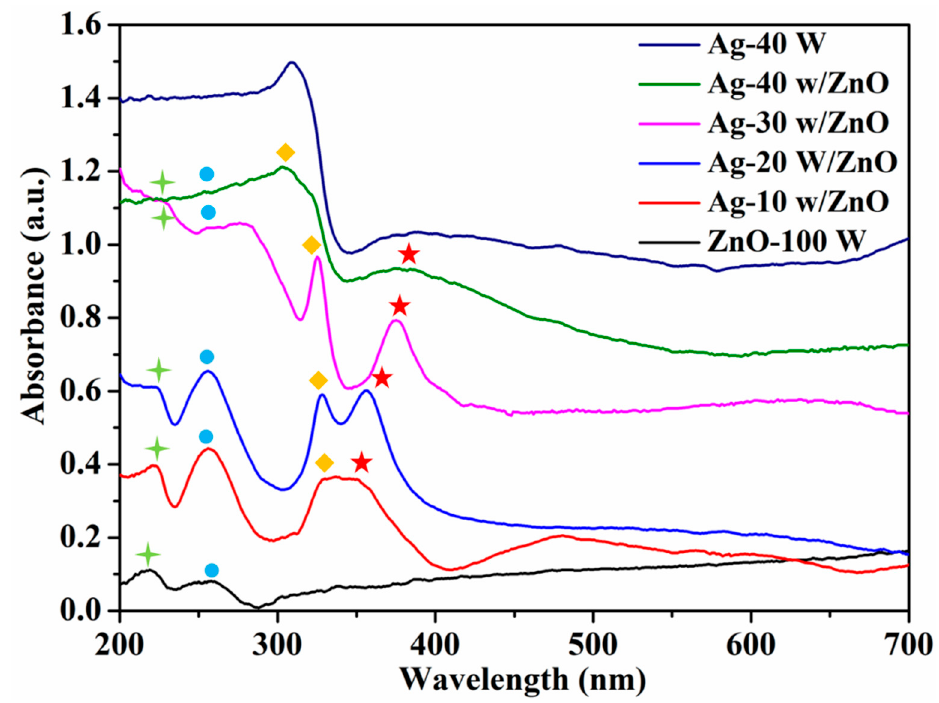
Figure 2. UV-Vis absorption spectra of the cosputtered Ag/ZnO systems and pure Ag and ZnO films. The sputtering power for ZnO in the Ag/ZnO systems is 100 W.